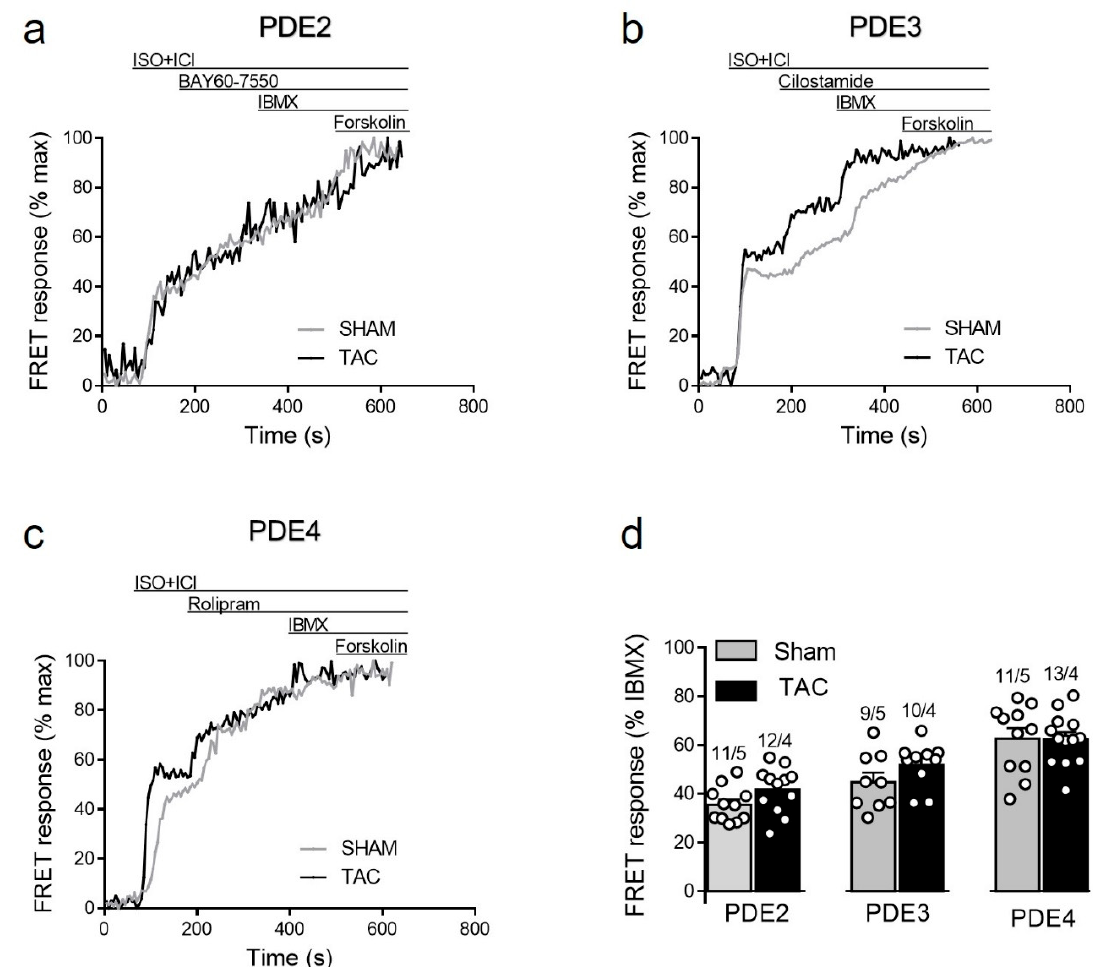
Figure 4. cAMP responses to selective PDE2, PDE3 and PDE4 inhibition after maximal β 1 -AR stimulation in sham and